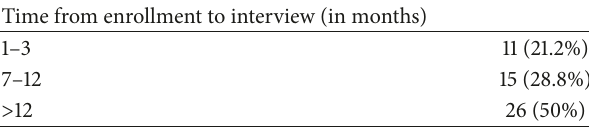
Table 1: Sampling of study